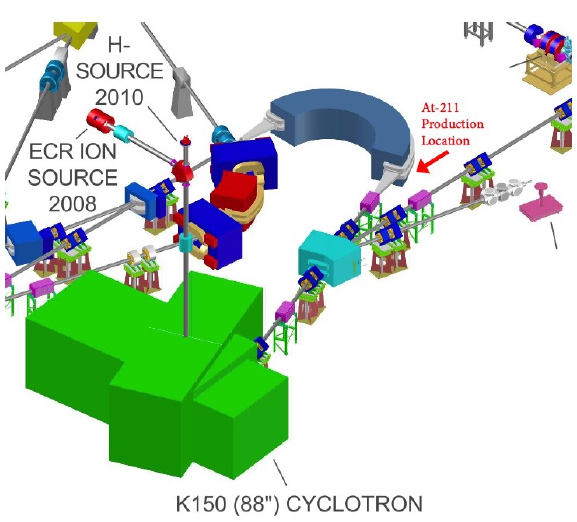
Figure 1. Isotope production line from K150